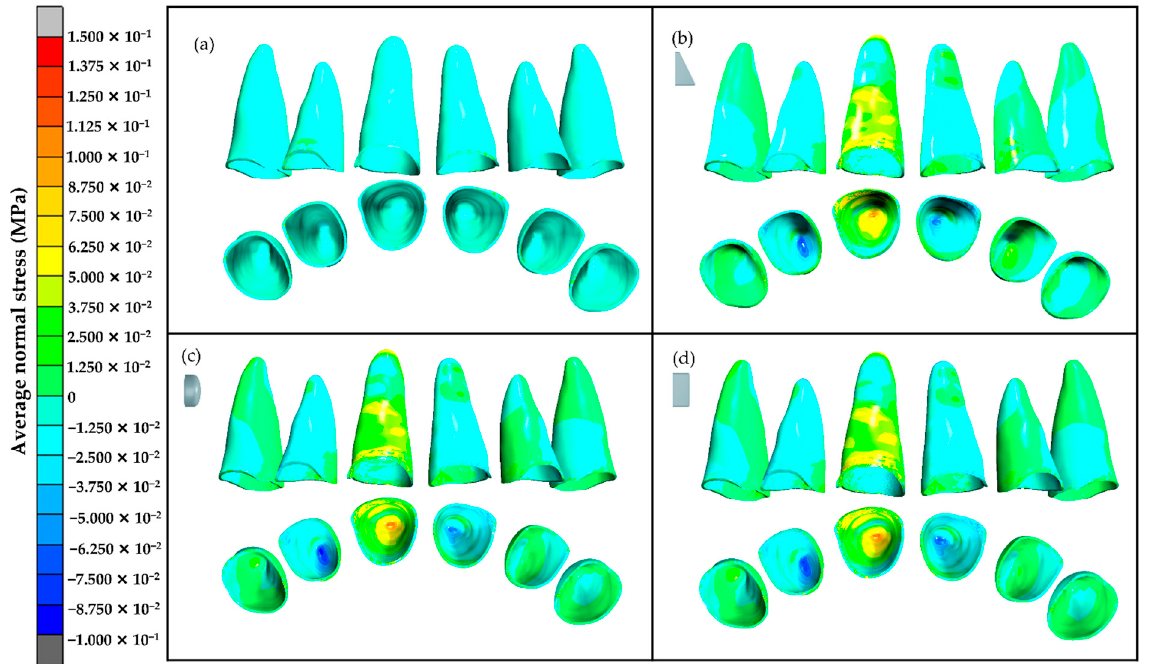
Figure 6. Distribution of the average normal stress at the upper anterior teeth PDL: ( a ) no composite attachment, ( b ) rectangular beveled attachment, ( c ) ellipsoid attachment, and ( d ) horizontal rectangular attachment.